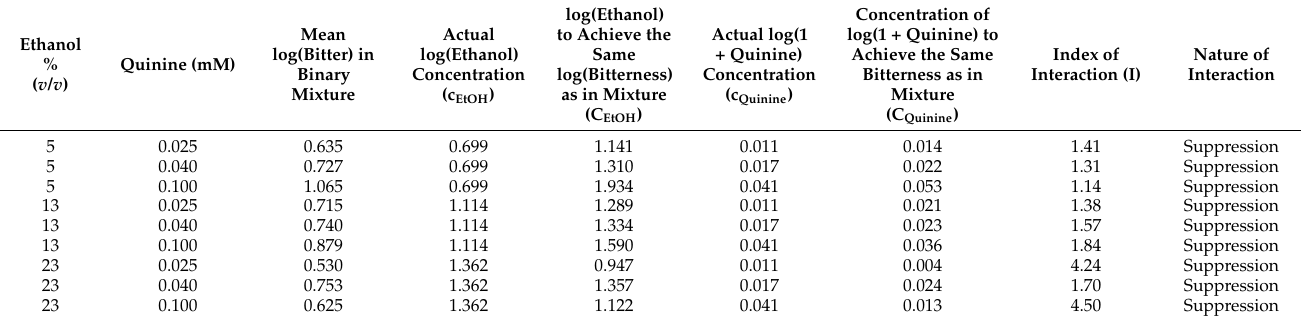
Table 3. Isobole calculations for bitterness interactions in binary mixtures of ethanol and quinine ( n = 35).